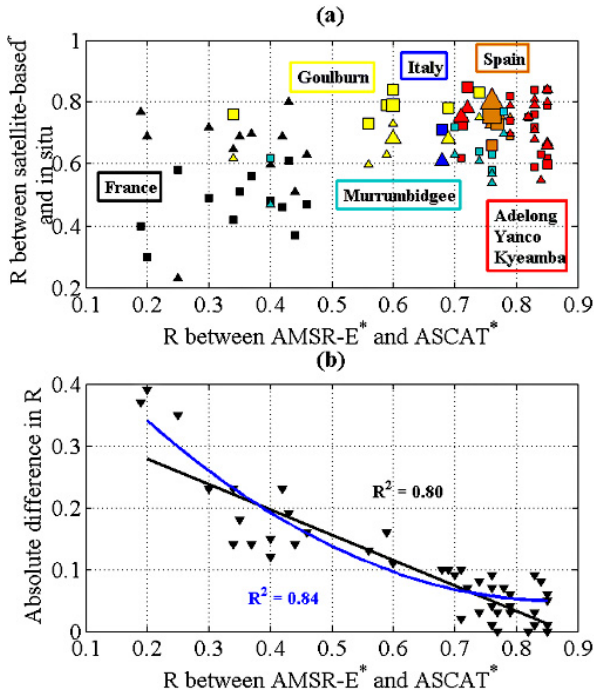
Fig. 7. (a) Plot of R between AMSR-E* and ASCAT* (horizon- tal axis) against their individual correlation coefficient with in situ measurement (vertical axis). Different catchments or basins are marked with different colors. Triangle and square symbols, re- spectively, represent R between in situ and ASCAT* and AMSR- E* soil moisture. The larger the symbol, the more in situ stations located within one 0.25 ◦ grid cell. (b) Plot of R between AMSR- E* and ASCAT* (horizontal axis) against the absolute difference between their individual correlation coefficient with in situ mea- surement (vertical axis). First-order and second-order polynomial regression lines are also